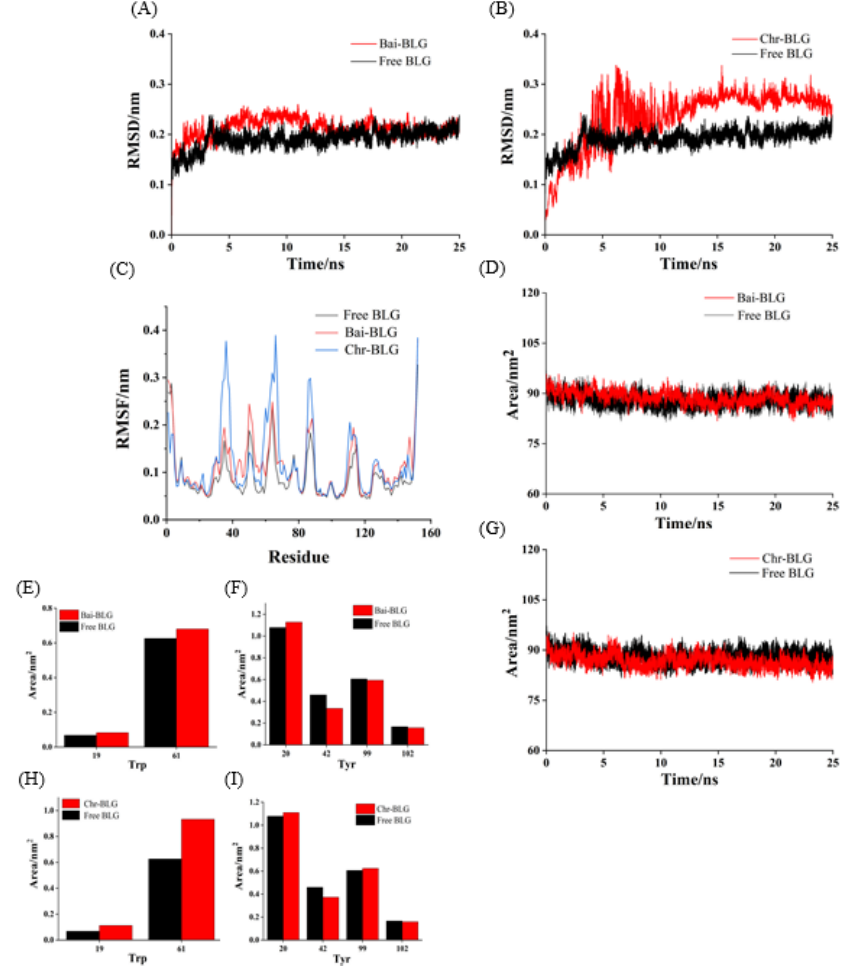
Figure 6. MD simulation of Bai/Chr with BLG for 25 ns. The RMSD ( A , B ) and RMSF ( C ) plots and SASA ( D , G ) of the complex and free BLG. The SASA of residues Trp ( E , H ) and Tyr ( F , I